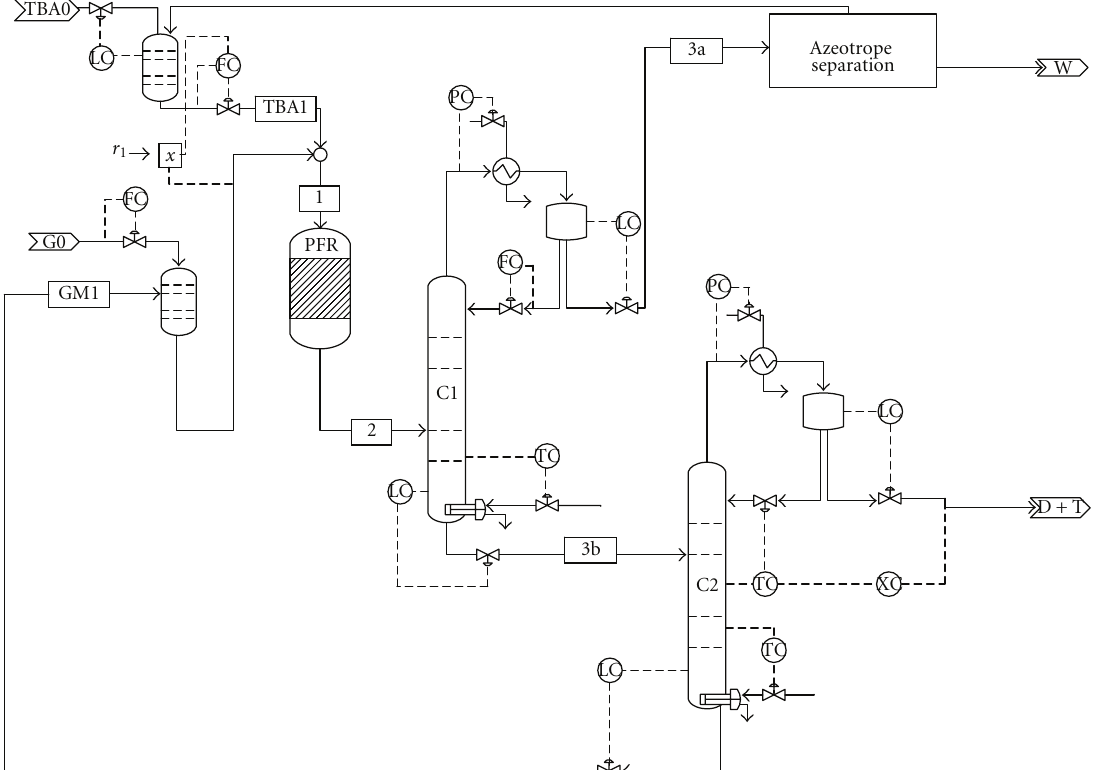
Figure 7: Flowsheet and control loops of the reaction section.